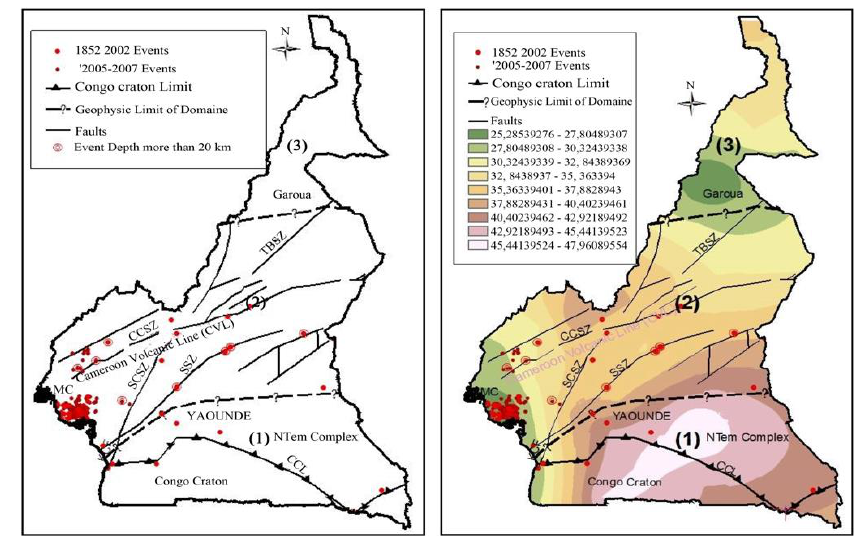
Figure 6. Seismicity map of Cameroon. Source: [12]. While the first SSR are associated with volcanic earthquakes, tectonic earthquakes of different intensity have occurred at the second to the fourth SSRs. One of the largest tec- tonic earthquakes to hit Cameroon was the 6.0 Mb magnitude earthquake that occurred